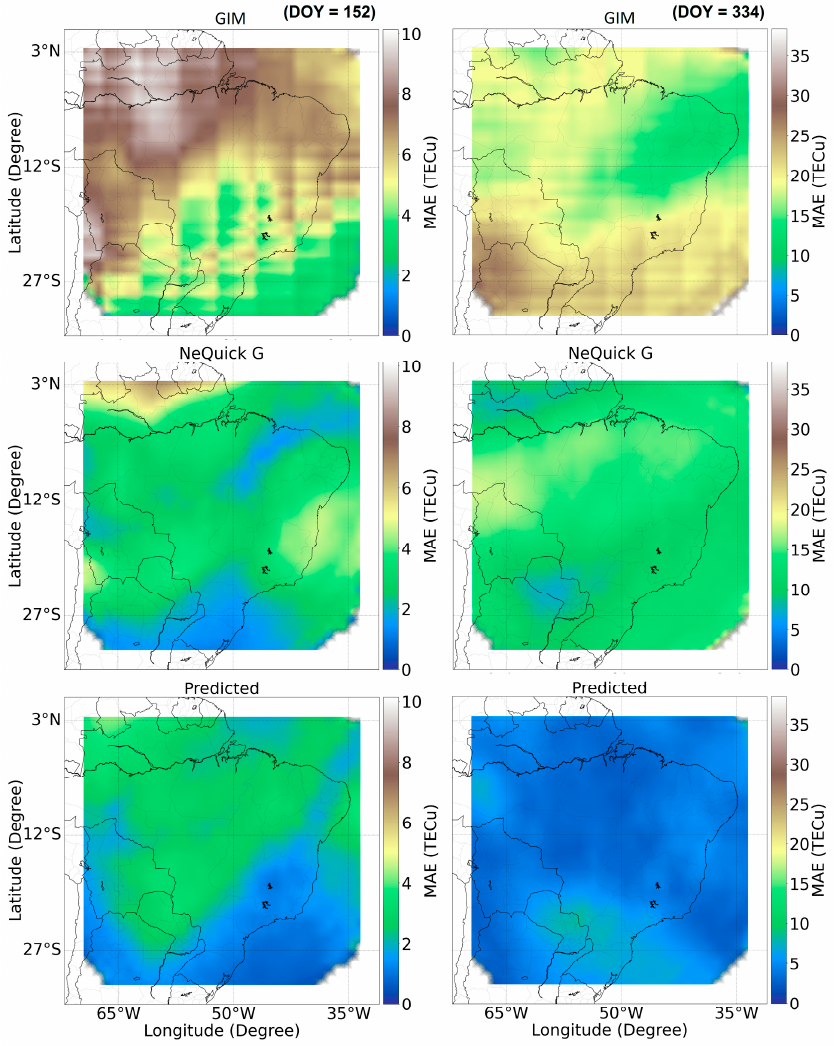
Figure 6. MAE for each point of the spatial grid coverage for the DoYs 152 ( right panels ) and 334 ( left panels ) as obtained by the MLP-NN ( lower panels ), NeQuick G ( middle panels ) and GIM ( upper panels ) for the year 2014 over